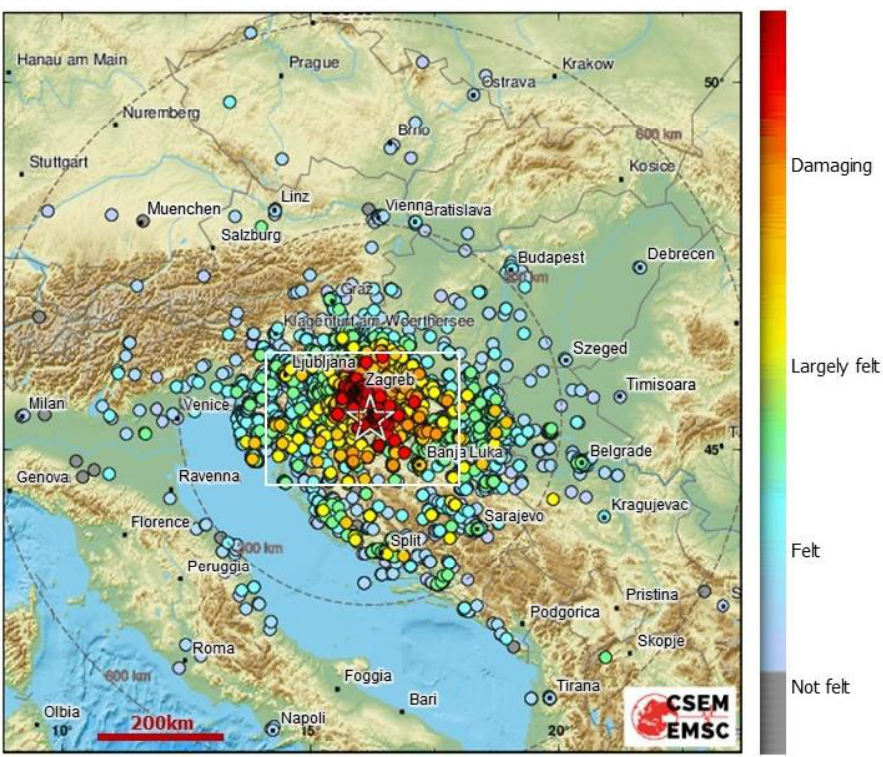
Figure 1. Felt reports for the Petrinja 2020 earthquake and epicentre location — marked with a star, from the European-Mediterranean Seismological Centre [3]. White rectangle shows the area presented in Figure 2.